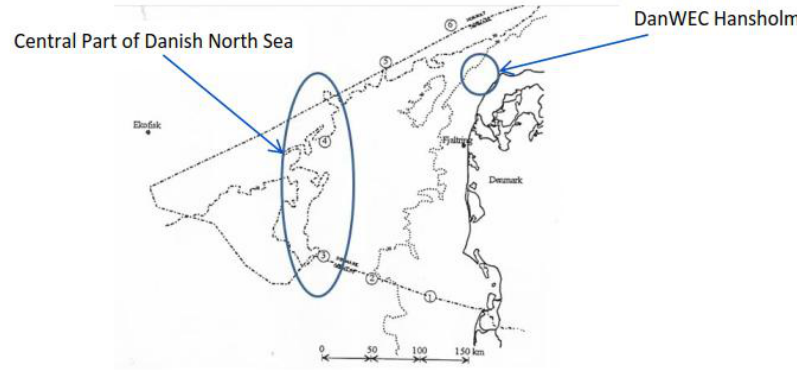
Figure 21. Map showing the location of the test site DanWEC and the central part of the North Sea where larger wave farms could be located.